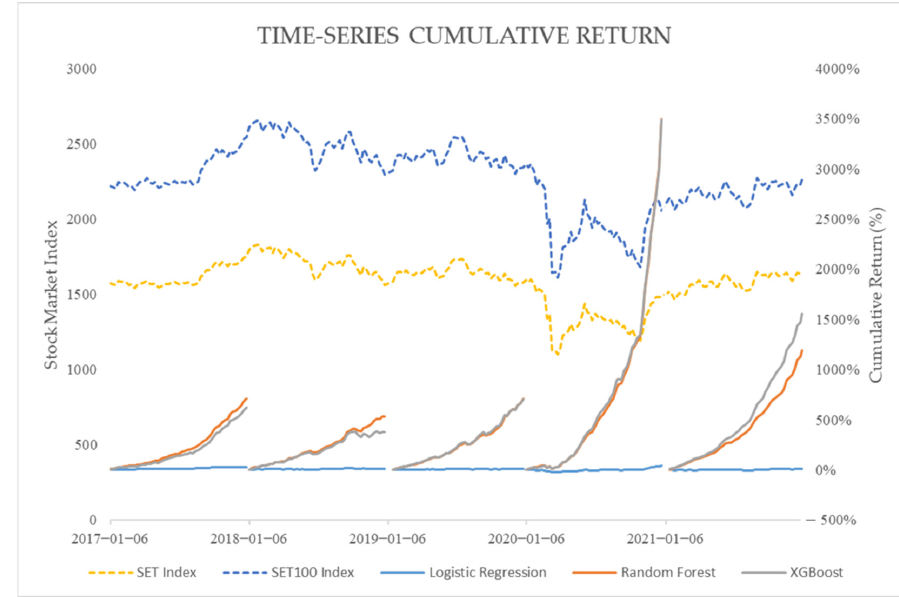
Figure 7. Time series cumulative return.